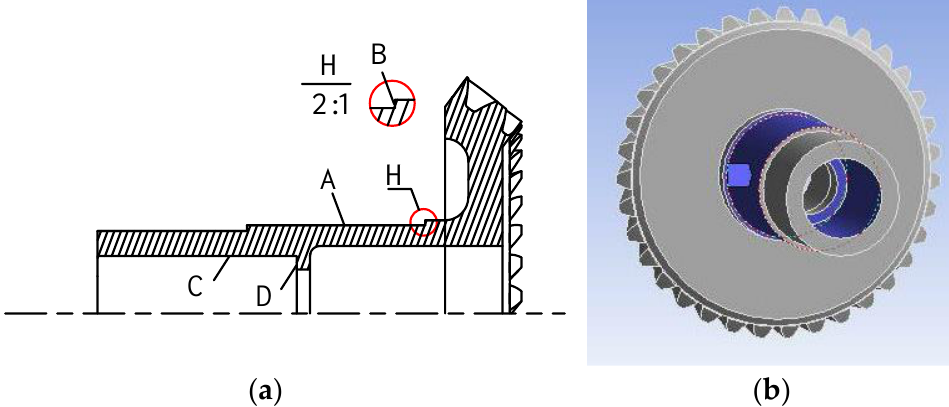
Figure 12. Constraint setting of driven bevel gear. ( a ) constraint diagram; ( b ) constraints in FEM model.